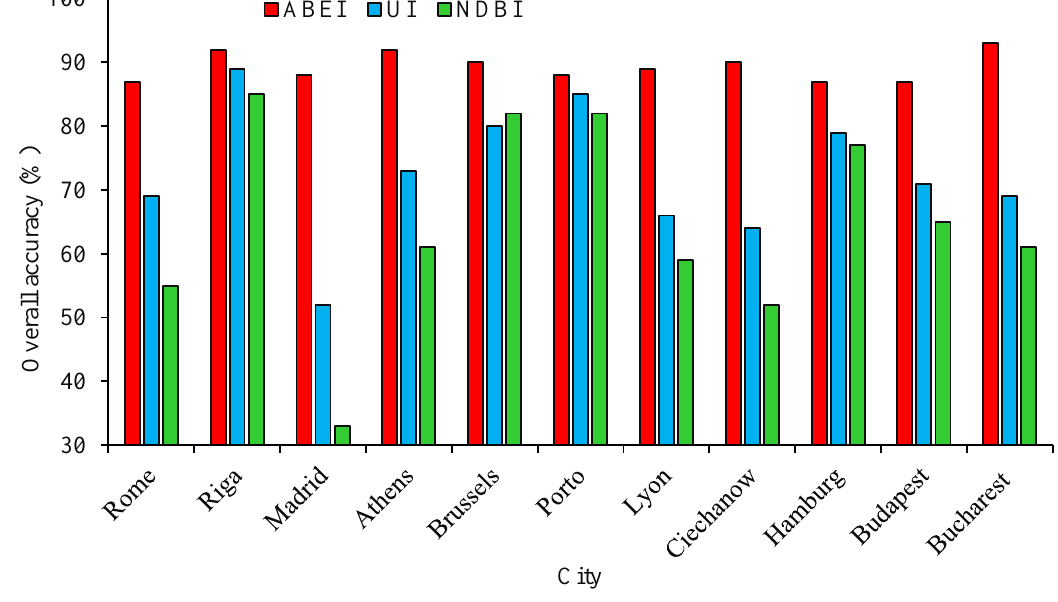
Figure 7. Overall accuracies of the three indices by city.